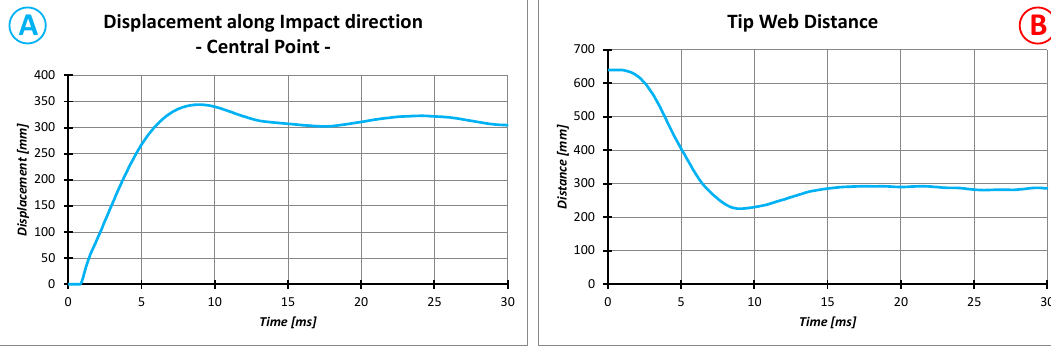
Figure 6. Numerical results. ( A ) Time-history of the displacement along impact direction of the skin central point; ( B ) tip web distance time-history.